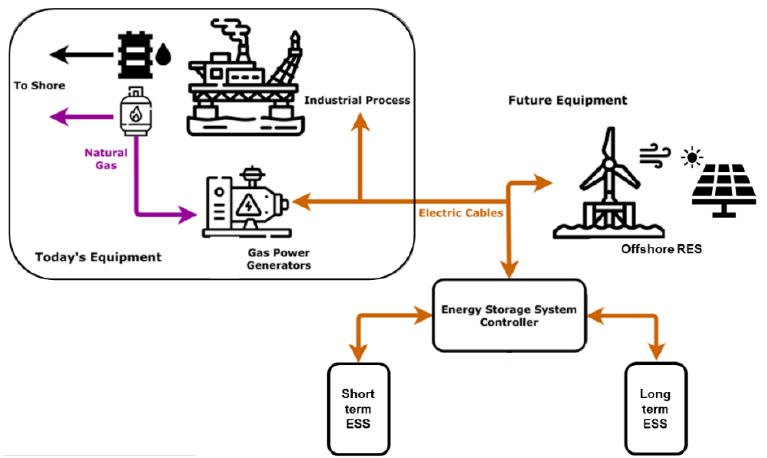
Figure 1. Integration of an offshore storage system into an oil and gas platform.